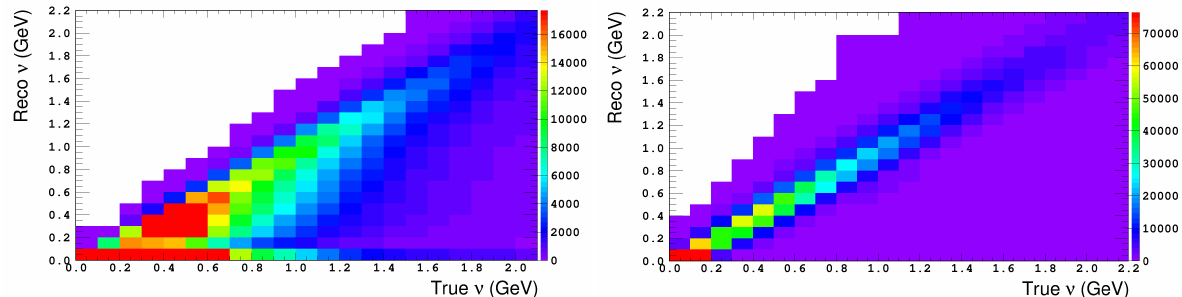
Figure 141. The reconstructed versus true ν in 3DST. ν is defined as the energy carried by all the particles except the charged lepton. The left figure shows the case where neutrons are not detected, while the right figure corresponds to the case where all the neutron energy is reconstructed via